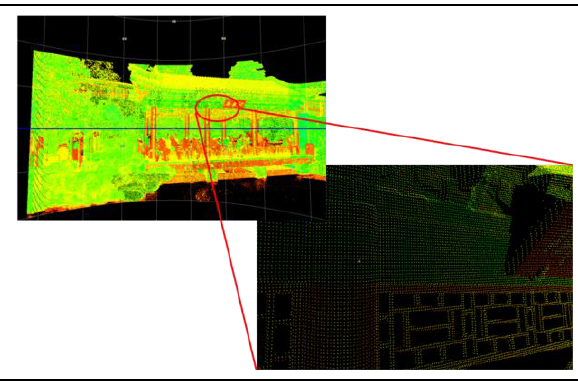
Figure 1. The domed scanning data: point image We define original scanned data with the array way as point image. The multi-view (multi-station) point images which are only registrated are called point image model. Point image